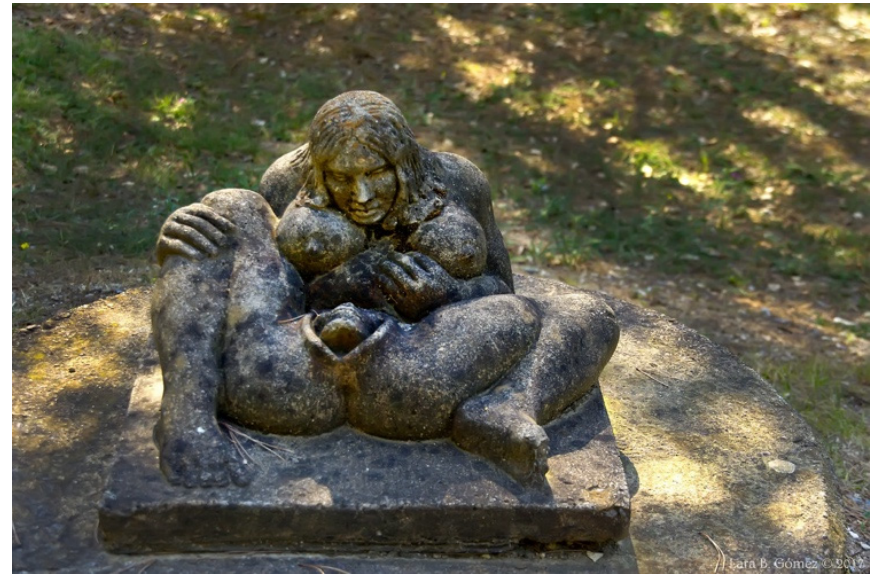
Figure 7. Xicu Cabanyes, Naixement de la mort (Birth of Death), 1980 . Photo by Lara B. Gómez, 2005, licensed under Creative Commons: CC BY-ND 2.0 .